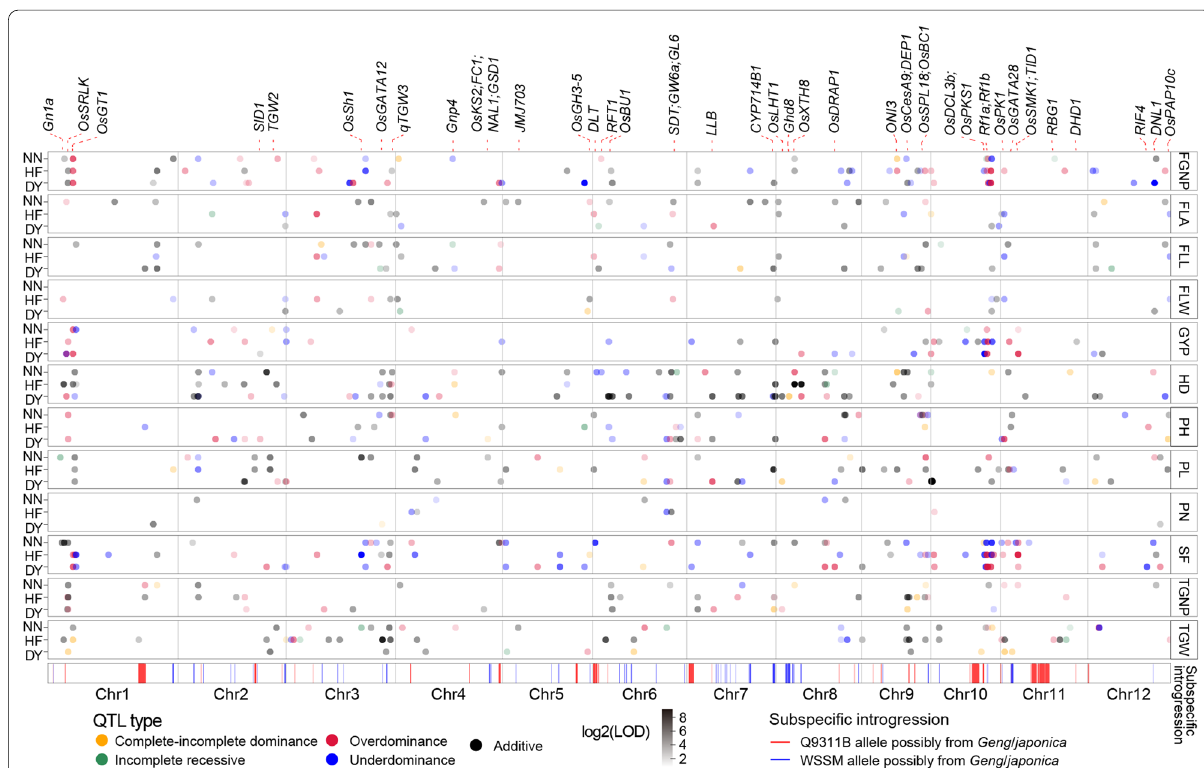
Fig. 2 Genomic distribution of 639 main-effect QTLs affecting 12 rice yield related traits identified in the combined (RIL Q9311/WSSM cross across three environments (Hefei [HF], Nanning [NN] and Deyang [DY]). On the top are 45 cloned rice genes of known effects on related traits and the bottom are 12 rice chromosomes. The bottom tile track highlights the distribution of genes with japonica / Geng allelic introgression in the parents of